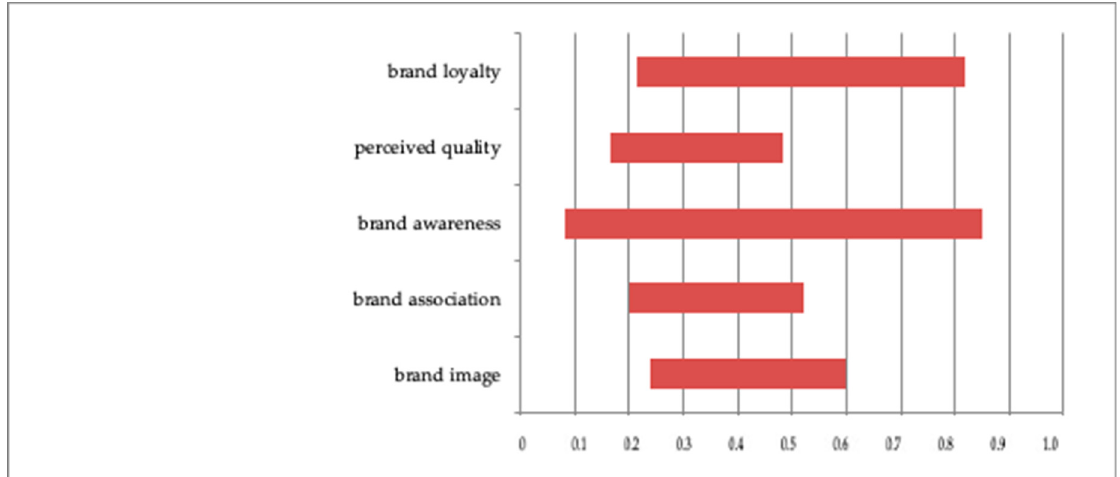
Figure 3. Path coefficient range for traditional determinants in SEM analysis.